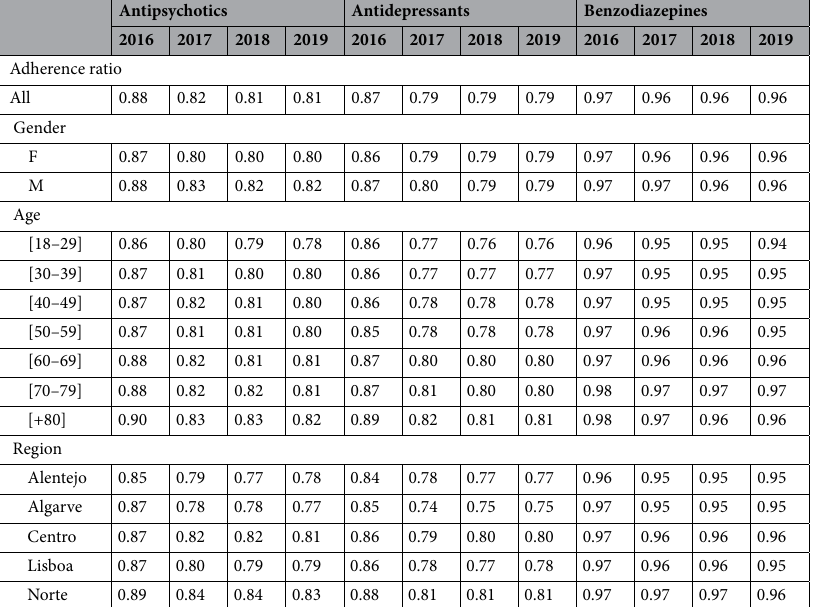
Table 2. Prescription adherence in Portugal: consumption to prescription DIDs